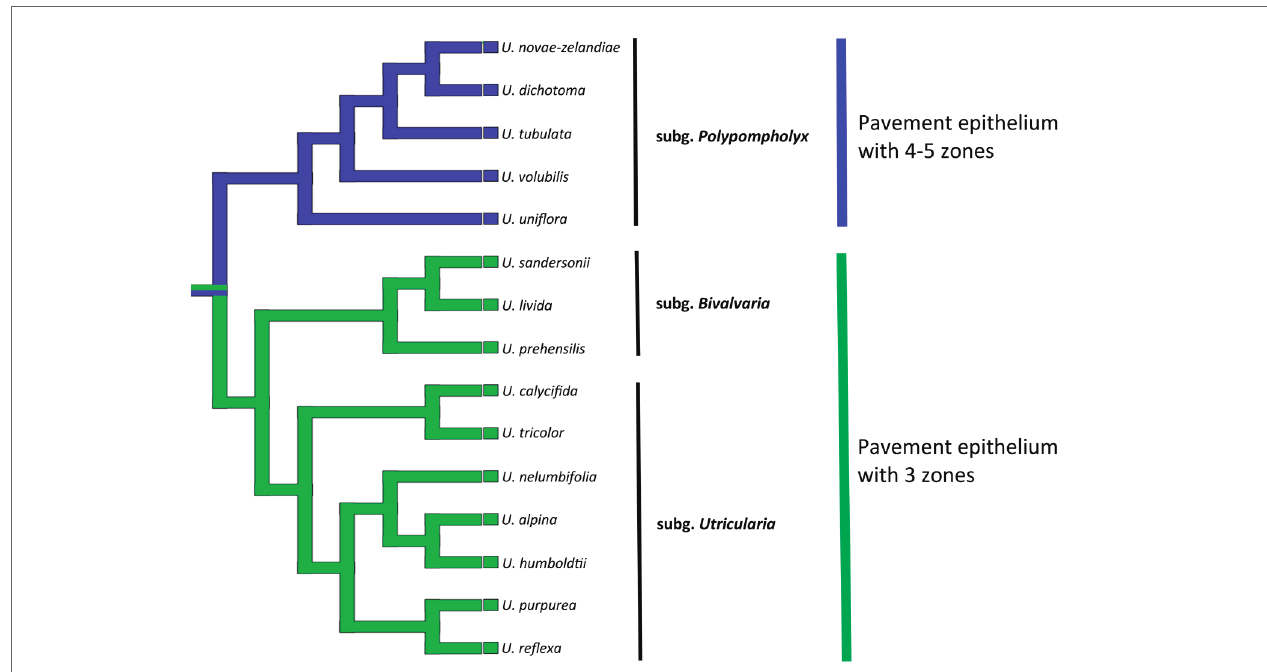
FIGURE 10 | Phylogenetic hypothesis for the pavement epithelium (states: 3 zones or 4–5 zones) for Utricularia lineages. The topology was adapted from Jobson et al. (2017), Rodrigues et al. (2017), and Silva et al.